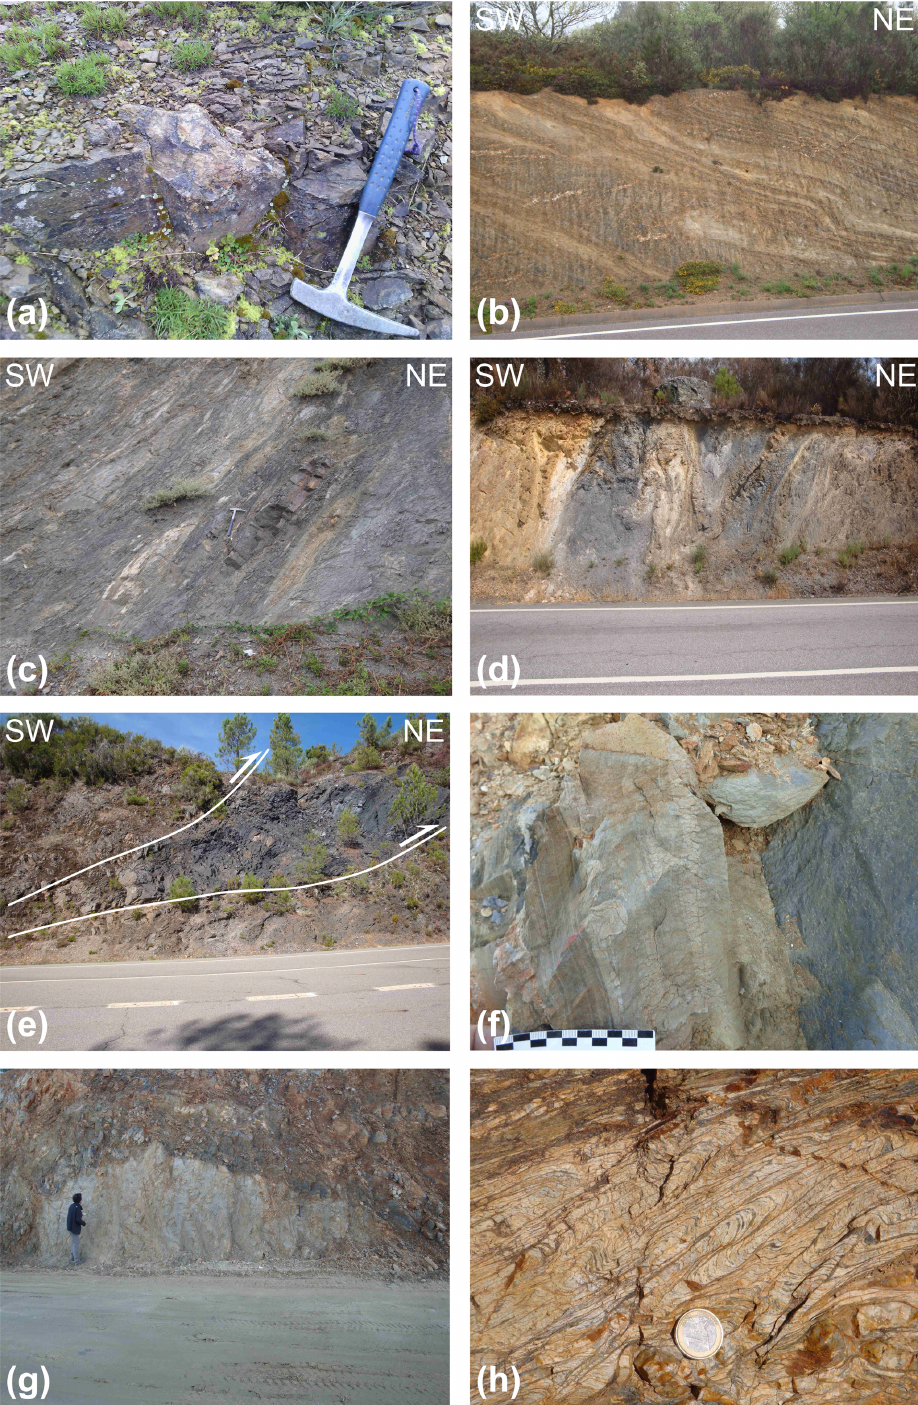
Figure 10. Field aspects of the block in matrix formations and olistoliths in the LPa. (a) Rhyolite block in the LPa northern Bragança Complex inside a quartzlitharenite; (b) flyschoid sequence in the Verín synform SW limb; (c) thrust band involving black Silurian ampelite, and rhyolite (whitish) and lydite (black) blocks in the NE limb of the Verín synform; (d) thrust band deforming rhyolite (yellowish and whitish), quartzlitharenite (brown in the right side) and ampelite (black) at the NE limb of the Verín synform; (e) black Silurian condensed facies in a tectonic slice inside a tectonic mélange at the NE limb of the Verín synform; (f) flyschoid sequence with sedimentary and load structures in the LPa at the easternmost part of the Verín synform SW limb; (g) olistolith made of UPa rocks displaying the characteristic arrangement of tectonic foliations in the LPa of the easternmost part of the Verín synform SW limb; (h) tectonic foliation array of the UPa lower part at the southwest of the Morais